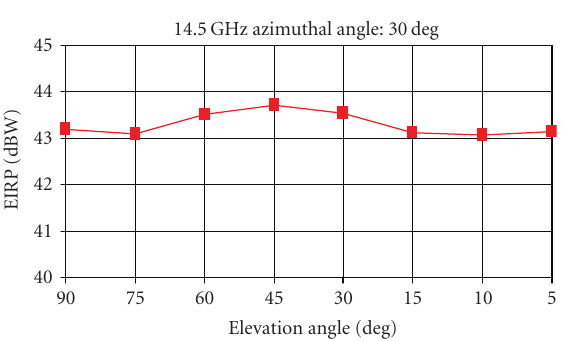
Figure 18: EIRP versus elevation angle over the horizon.